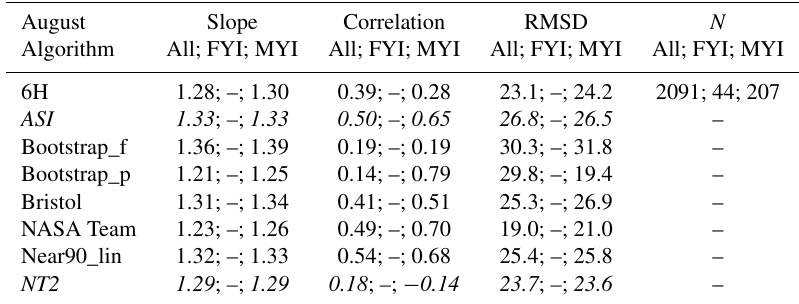
Table 10. Statistical parameters of the comparison AMSR-E sea-ice concentration vs. MODIS ice-surface fraction for MODIS sea-ice concentration > 90% (see Fig. 5) for August 2009. Each column gives the value for all grid cells with MODIS sea-ice concentration > 90%, and the respective multiyear (MYI) and first-year ice (FYI) grid cells. Values obtained for the ASI and NT2 algorithm are shown for completeness but are in italic